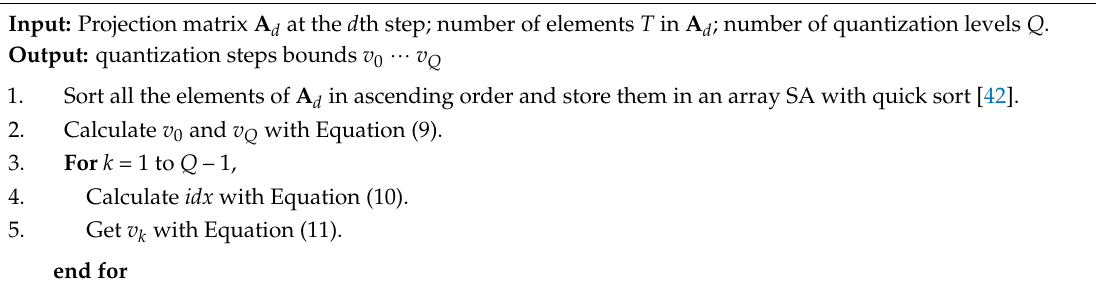
Algorithm 2. The proposed data quantization